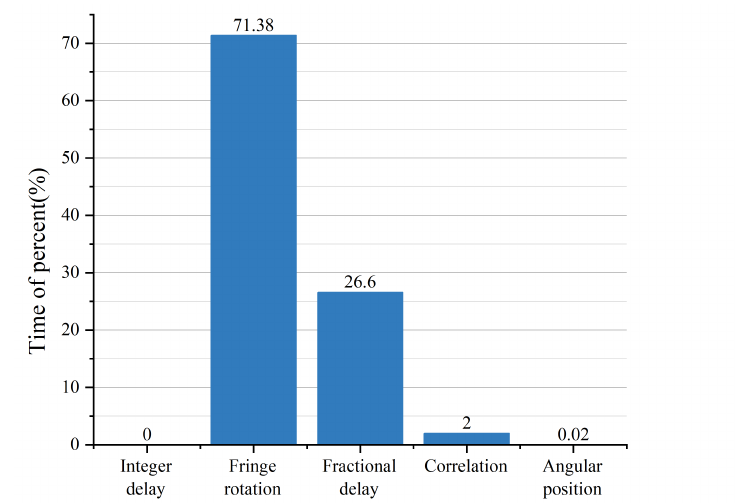
Figure 3. Time proportion of each part in the serial version.